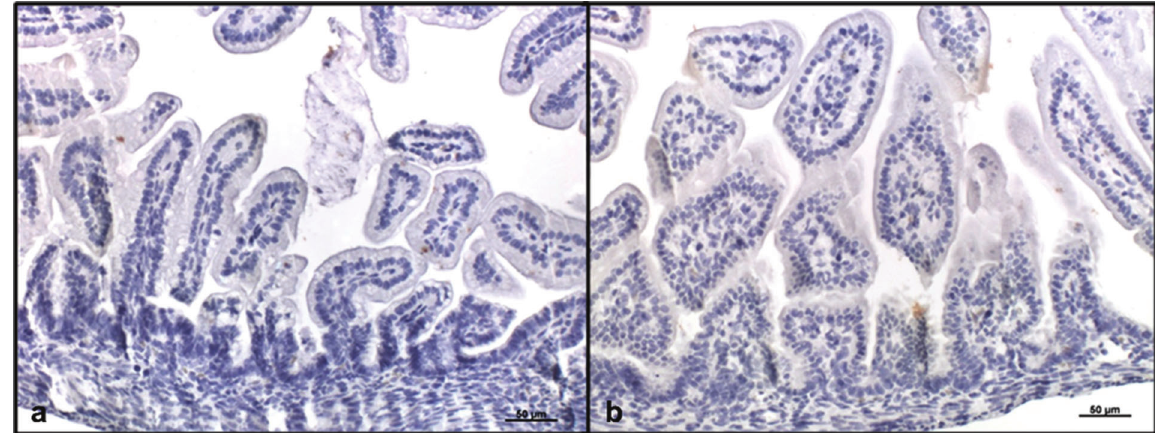
Figure 5 - Negative control. Photomicrographs show the negative controls for immunohistochemistry. a) Ileum. b) Jejunum (scale bar=50 m m).